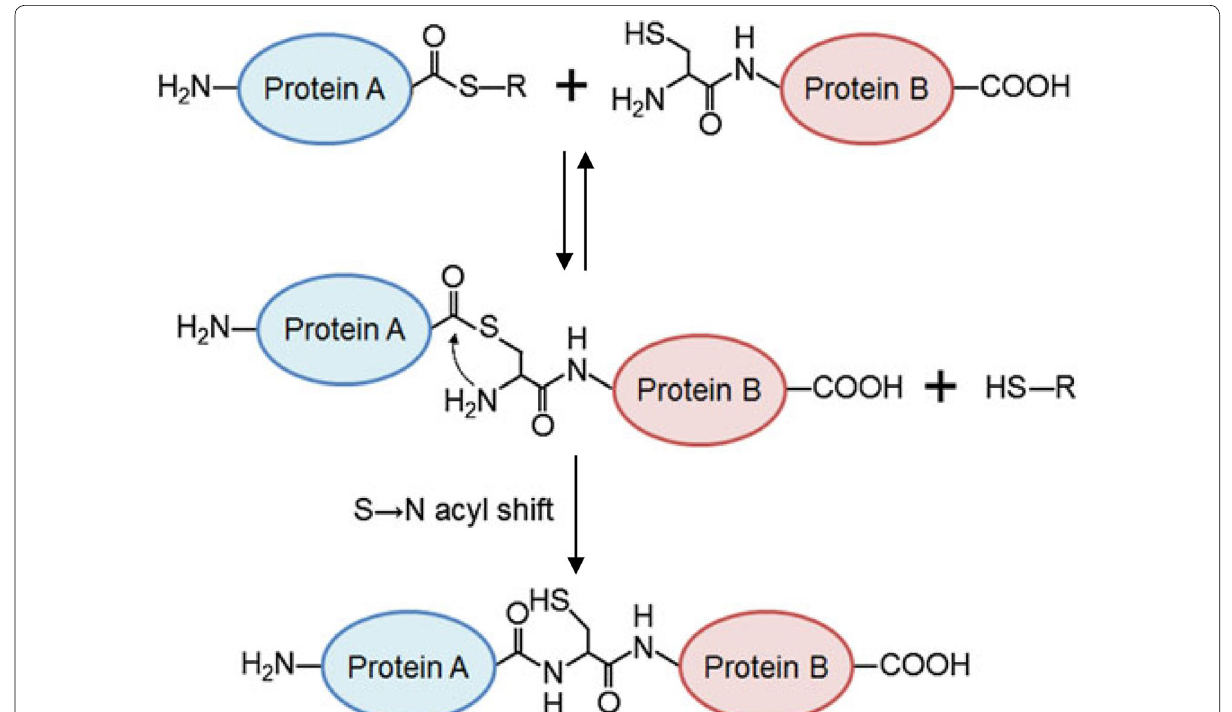
Fig. 21 Native chemical ligation. Native chemical ligation (NCL) is a chemoselective coupling reaction that links a peptide fragment containing an N-terminal Cys (α-Cys) residue and another peptide fragment bearing a C-terminal α-thioester group by a native peptide bond (Figure reproduced with permission from: Ref. [106]. Copyright (2012)